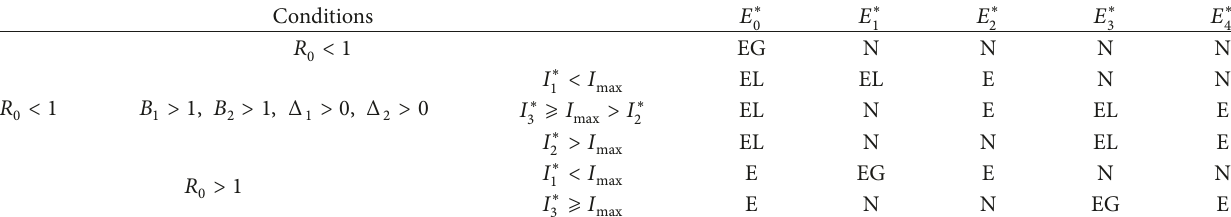
Table 2: Main result of Section